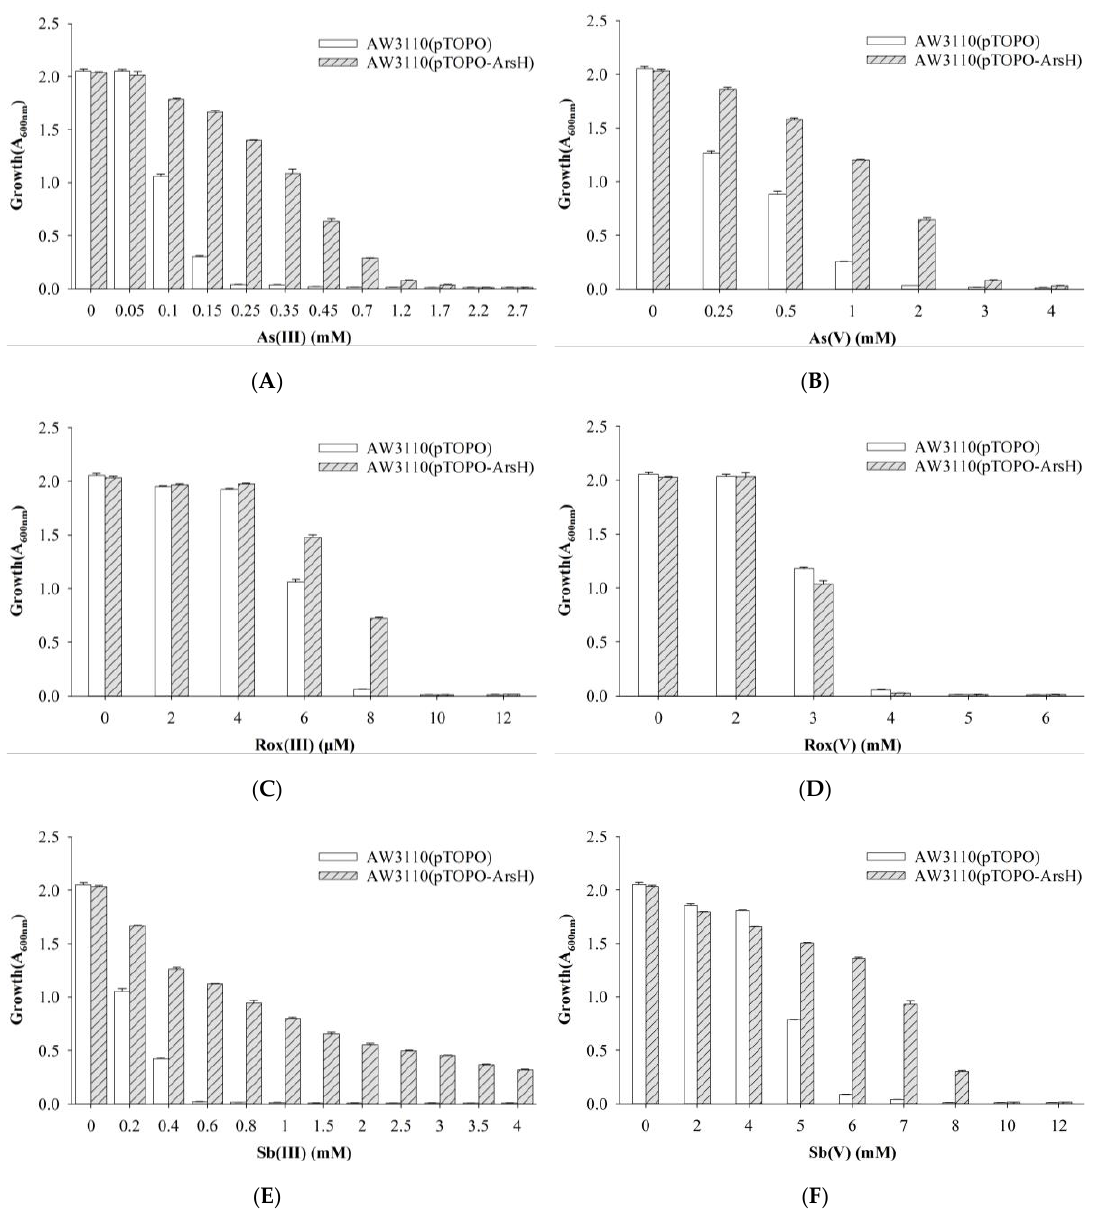
Figure 5. Growth of E. coli AW3110 bearing pTOPO and pTOPO-ArsH with the indicated concentrations of As(III) ( A ), As(V) ( B ), Rox(III) ( C ), Rox(V) ( D ), Sb(III) ( E ), and Sb(V) ( F ). The A 600 nm was measured after 24 h of growth at 37 °C and 220 rpm. The graphs show the results of three replicates, and error bars represent the standard error of the average values.